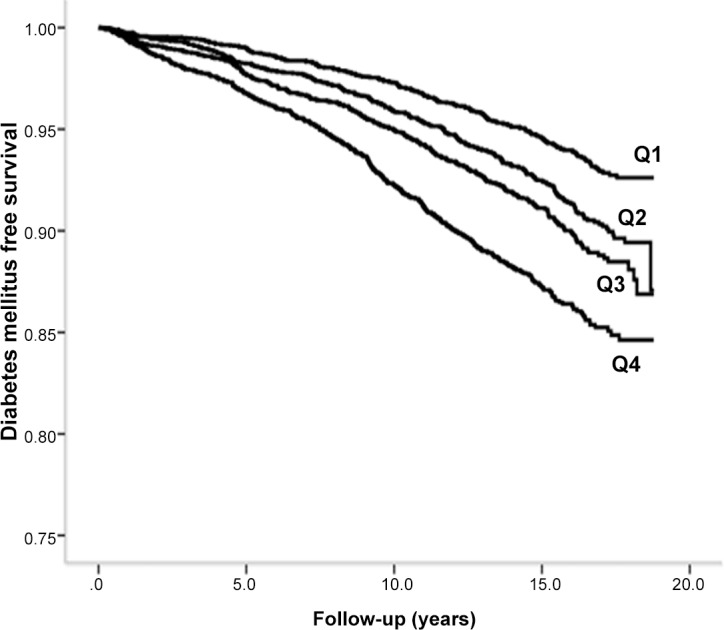
Diabetes mellitus free survival in relation to quartiles of total leukocytes in women.